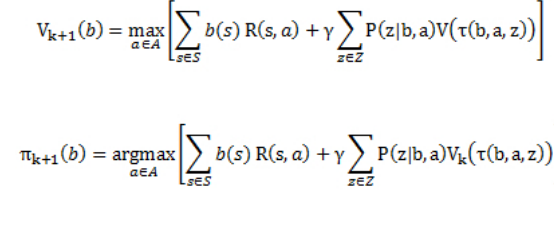
Figure 5. Belief b(s) of being in